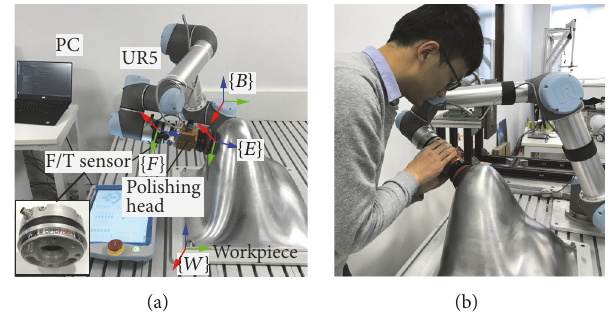
Figure 6: Polishing workstation. (a) Setup of the polishing work- station. The workpiece is manufactured as a complex surface of the aluminium alloy with an overall dimension 400 mm × 400 mm × 300 mm . (b) Kinesthetic teaching via a